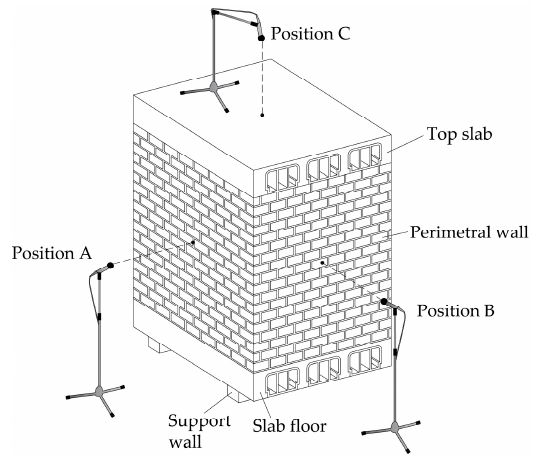
Figure 7. Location of the microphone with respect to the cells.